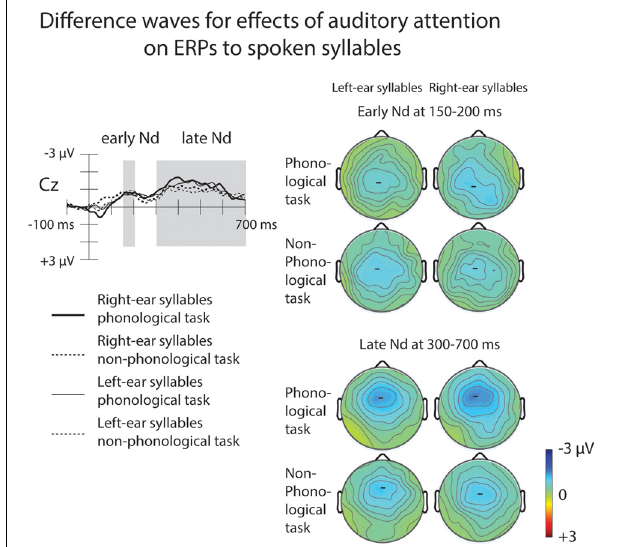
FIGURE 4 | Effects of auditory attention on ERPs to the left-ear and right-ear syllables illustrated by difference waveforms at the Cz electrode. The difference waves were obtained by subtracting grand-average ERPs to the left-ear standard syllables during right-ear phonological and non-phonological tasks from grand-average ERPs to the left-ear standard syllables during left-ear phonological and non-phonological tasks, respectively, and by subtracting ERPs to the right-ear standard syllables during left-ear phonological and non-phonological tasks from ERPs to the right-ear standard syllables during right-ear phonological and non-phonological tasks, respectively (for the grand-average ERPs, see Figure 3A , top row). Maps on the right show scalp distributions for the early negative-difference (Nd) effect (150–200ms from syllable onset) and late Nd effect (300–700ms from syllable onset) determined after measuring, in each participant, the mean Nd amplitude at each electrode over these time windows marked in the difference